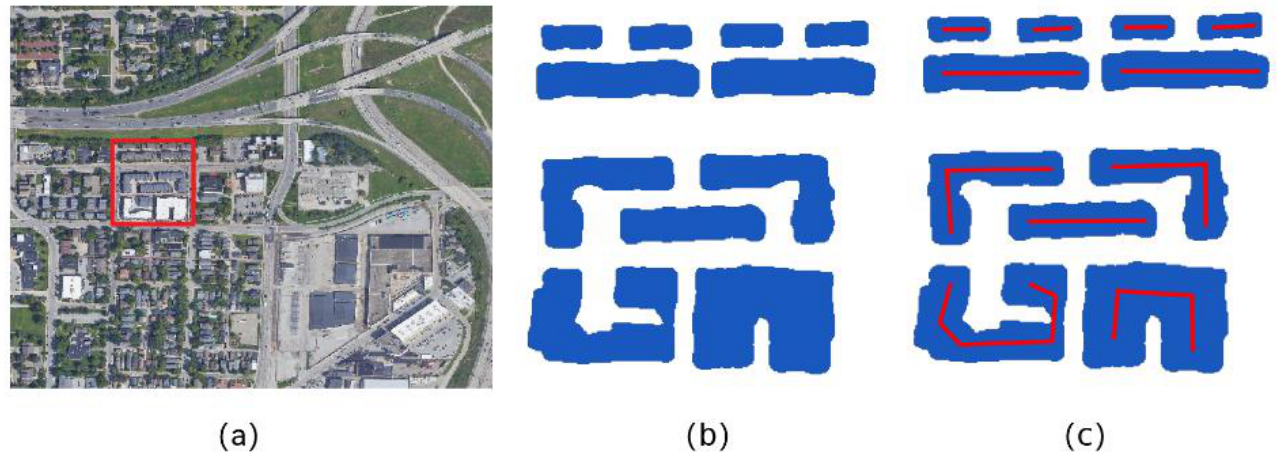
Figure 16. ( a ) High-resolution remote sensing images. The highlighted red box area in ( a ) corresponds to ( b , c ); ( b ) Initially extracted vector buildings; ( c ) Skeleton line extraction results based on the proposed VRDI approach as shown by the red solid line.